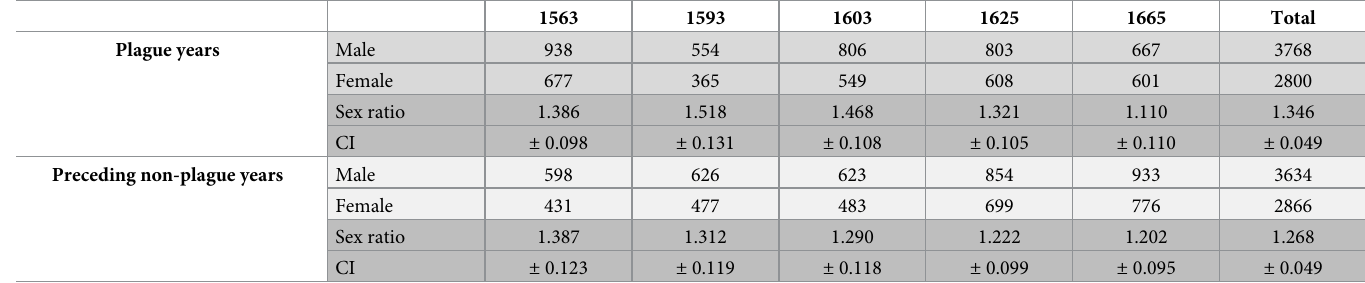
Table 2. A comparison between the frequency of all male and female burials for five plague years and the preceding non-plague years in sixteen parishes. The com- bined totals for plague and non-plague years are also